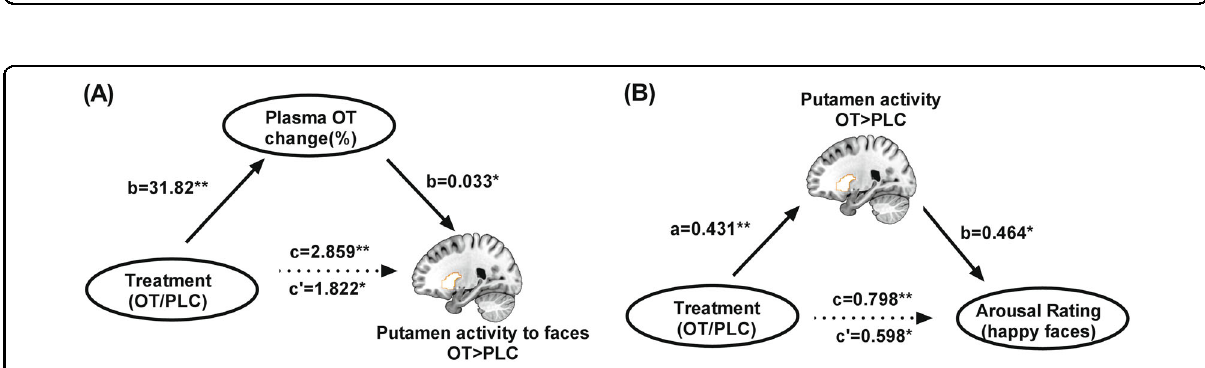
Fig. 2 Effects of oral oxytocin (OT) on intensity and arousal ratings for different face emotions. A OT increased intensity ratings to all face emotions. B OT increased emotional arousal ratings to all face emotions but to angry and happy faces more than others. PLC placebo. * p FDR < 0.05 (all faces), + p FDR < 0.05 (for speci fi c emotional faces). Bars indicate 95% con fi dence intervals and medians.